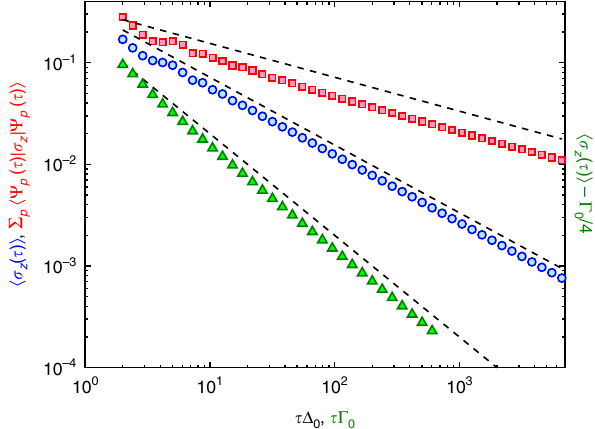
Fig. 1 The numerically determined defect density. We plot the defect density from the normalized (blue circles) and unnormalized wavefunction (red squares) for the PT-symmetric ramp, as well as for the full non- hermitian drives (green triangles), measured from its adiabatic value. The black dashed lines denote the τ − 1/3 , τ − 2/3 , and τ − 1 scaling. The cutoff | p | < W = 10 Δ Γ 0 and 10 0 , respectively, does not alter the dynamics, with other values yielding similar scaling